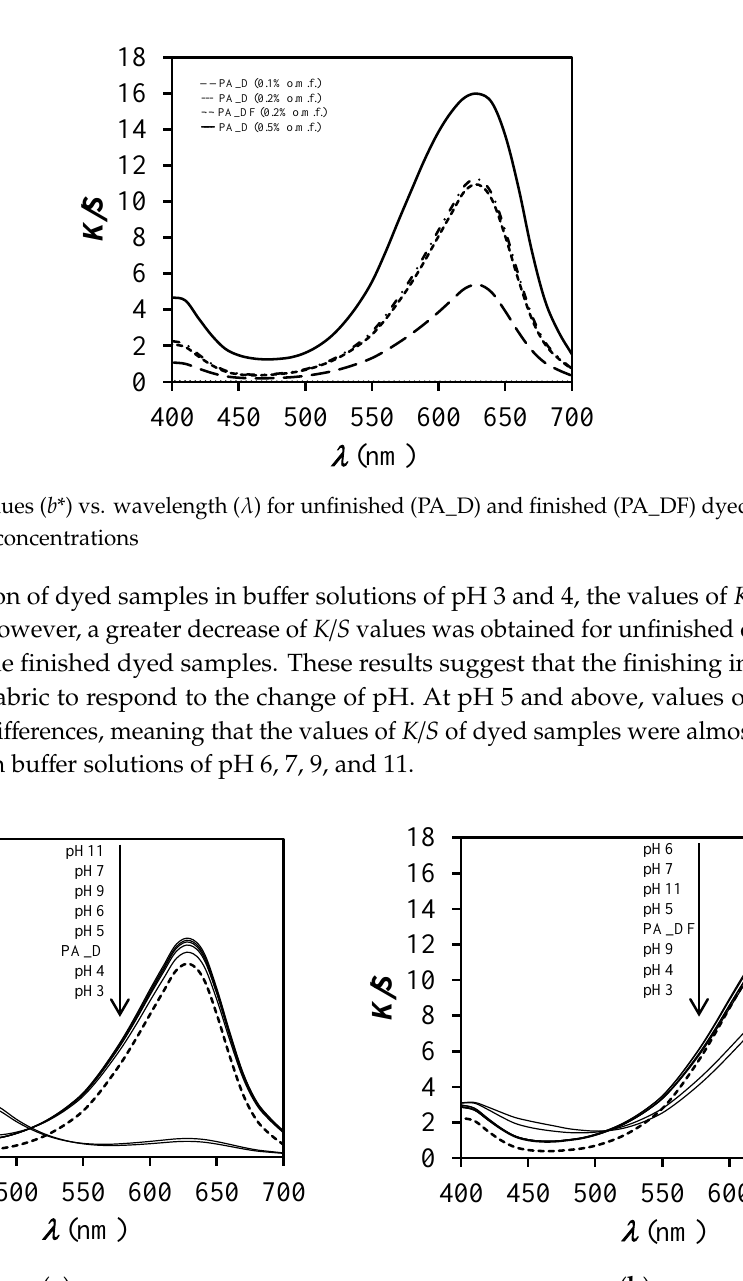
Figure 4. Creases on polyamide 6 (PA6) fabric dyed with dye concentration of 0.2% on mass fabric (o.m.f.).